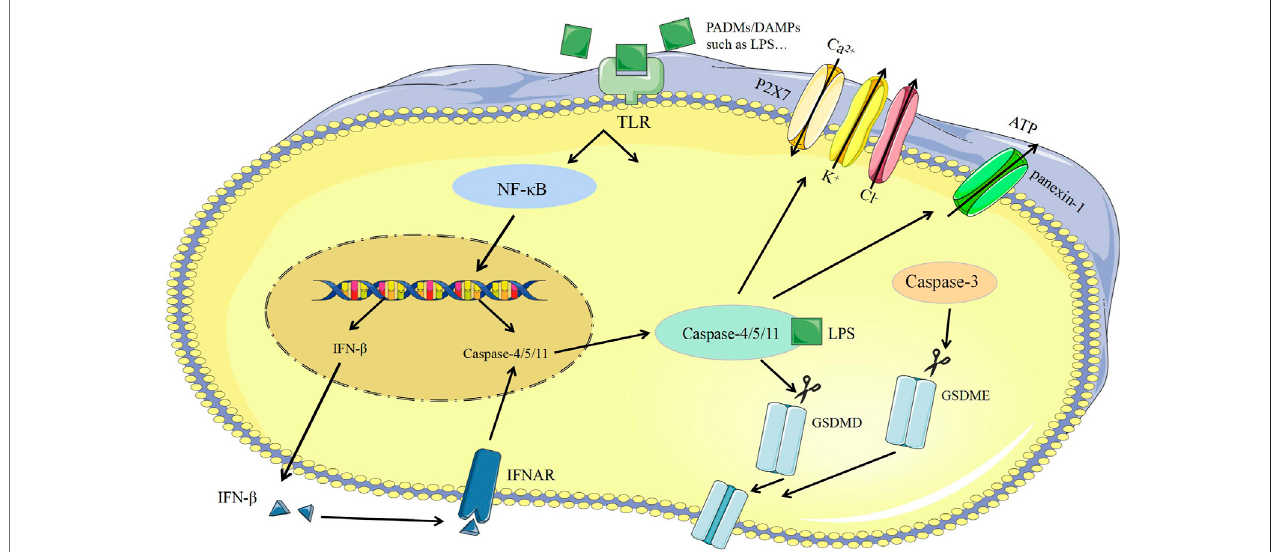
FIGURE 3 | Caspase-1-independent pyroptosis. ATP, Adenosine triphosphate; Caspase-3, cysteine-aspartic proteases-3; Caspase-4, cysteine-aspartic proteases-4; Caspase-8, cysteine-aspartic proteases-8; Caspase-11, cysteine-aspartic proteases-11; DAMPs, damage-associated molecular patterns; GSDMD, gasdemin D; GSDME, gasdemin E; IFN- β , Interferon- β ; IFNAR, interferon- α / β receptor; LPS, lipopolysaccharide; NF- κ B, nuclear factor kappa-B; PAMPs, pathogen- associated molecular patterns; P2X7, purinergic receptor; TLR, Toll like receptor.